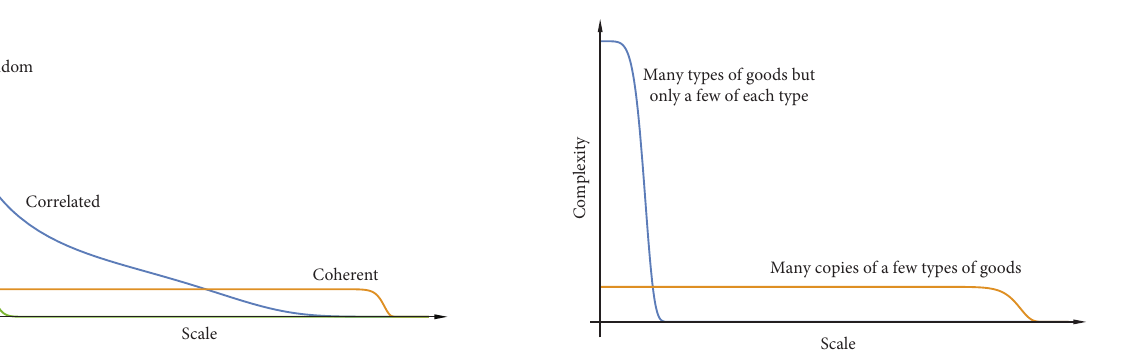
Figure 3: The complexity profile of a factory that can produce a large number of copies of a few types of goods, and the complexity profile of a factory that can produce many types of goods but not in large numbers. The number of copies of a good produced is a proxy for scale since, given a fixed technology, mass production requires larger-scale coordinated action in the factory (e.g., an assembly line). The number of different types of goods that can be produced at a given scale is a proxy for the number of different possible behaviors of the factory—and thus its complexity—at that scale.